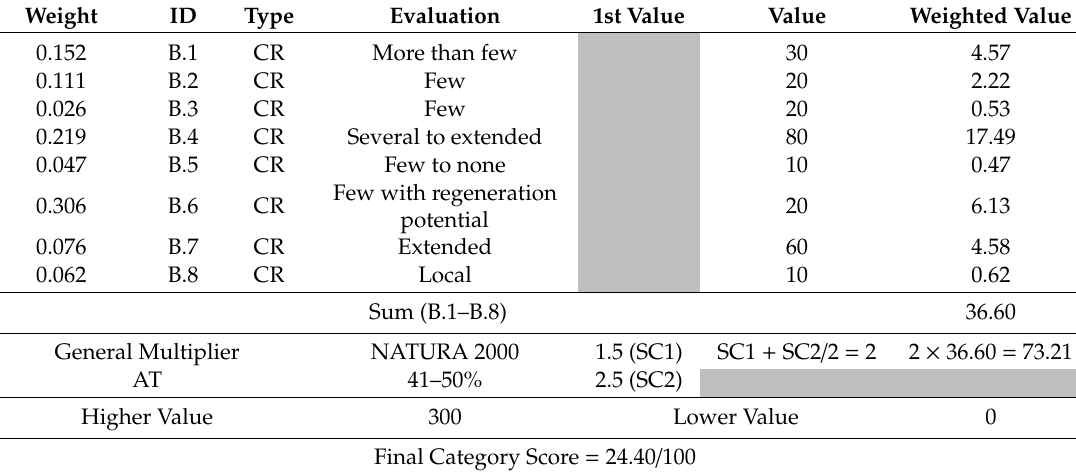
Table A16. Evaluation table of general environmental impacts after the Evros fire. CR: criterion; AT: additive term; SC: Summed score. Original matching table: A2. Gray color: denotes a non-applicable or not available